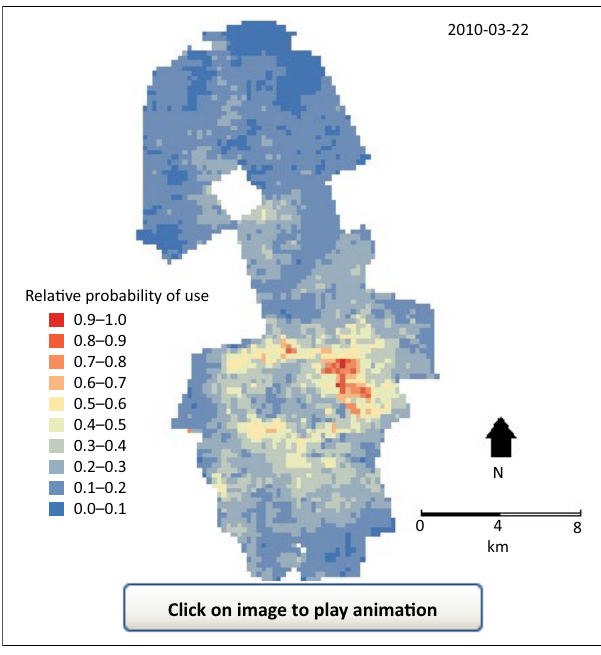
FIGURE 3-A4: Animation of predicted space use by female elephants in the afternoon (16:00) in Addo Elephant National Park, South Africa. Predicted use reflects step selection function model predictions to the elephant-accessible Main Camp – Colchester section of Addo Elephant National Park for 16-day periods from 06 March 2010 to 21 March 2013, corresponding to the Moderate Resolution Imaging Spectroradiometer composites used for analysis (see the main text for details).